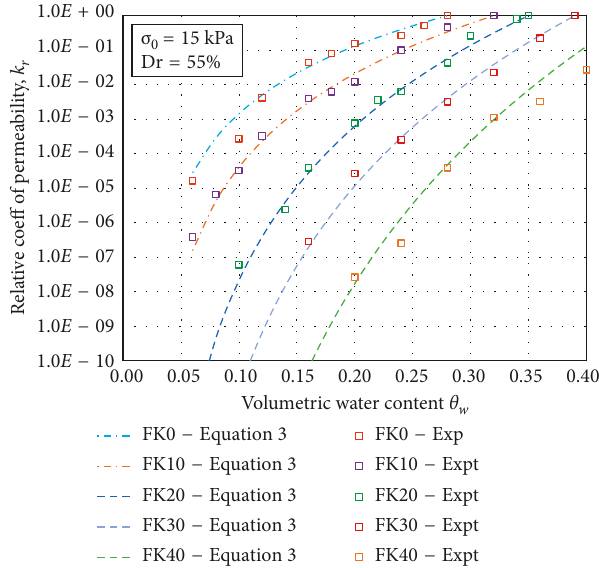
Figure 16: Comparison of figures of permeability changes against volumetric water